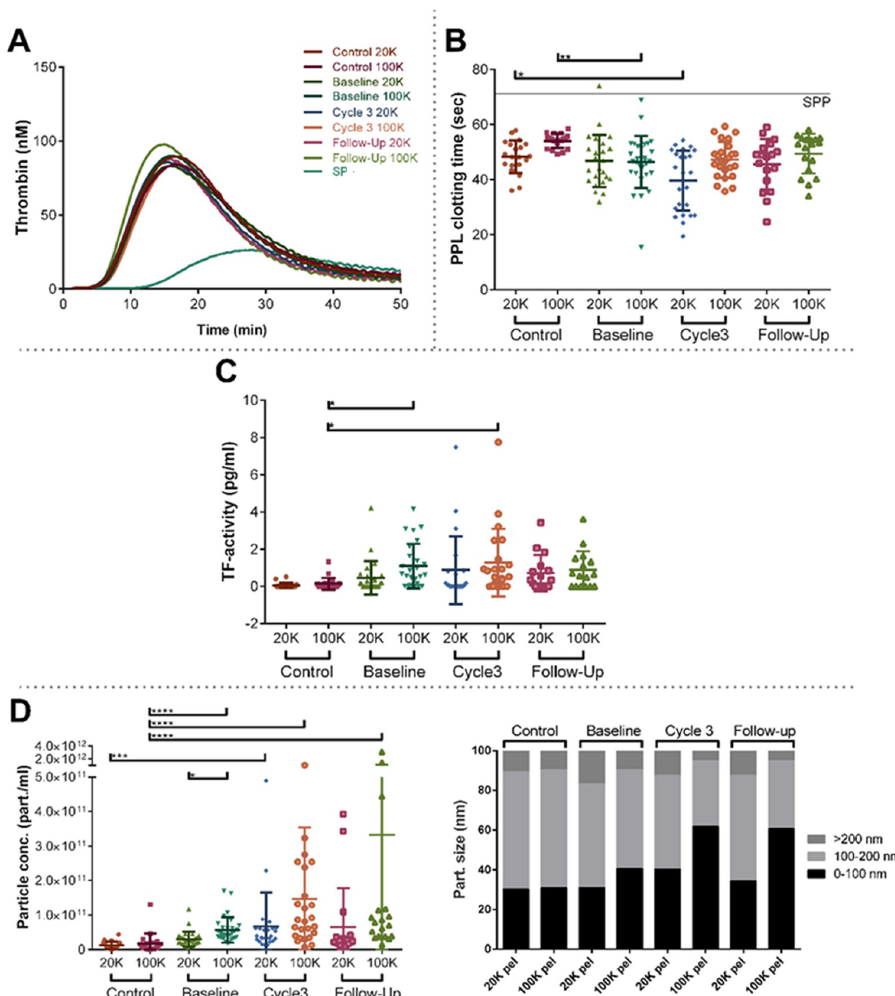
Fig 2. Procoagulant profiling of EVs isolated from healthy age-related controls and SCLC patients at baseline, during (prior to cycle 3) and after treatment (follow-up). A) Thrombin generation curves from standard plasma (SP) and SP-containing vesicles isolated from patients and controls. B) EV-associated activity of procoagulant phospholipids (PPL) depicted as a clotting time. In both A) and B) SP represents the coagulation activity of the standard pooled plasma into which the isolated vesicles have been added. C) difference in tissue factor (TF) activity associated with EVs D) concentration and size distribution of isolated vesicles in both pellet types i.e. 20K pel and 100K